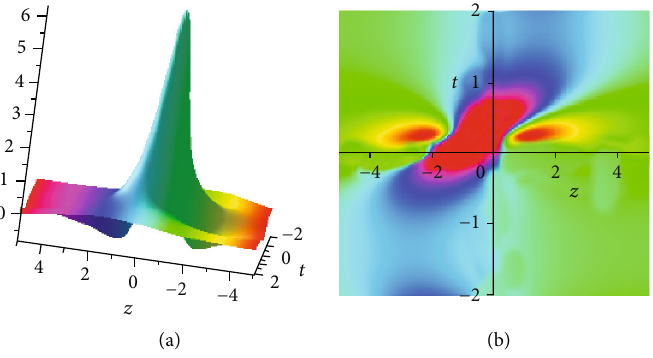
Figure 19: Plots of lump-periodic (77).